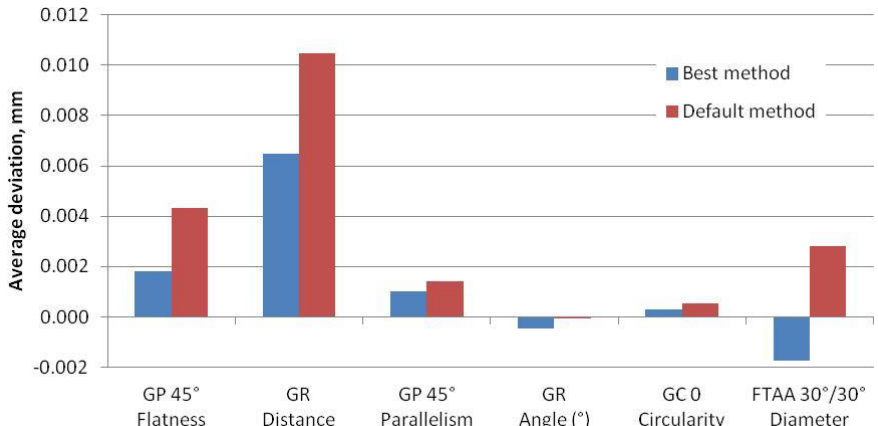
Figure 8. The average deviations for the measurements of the multi-feature check using the default and the best path control algorithms.